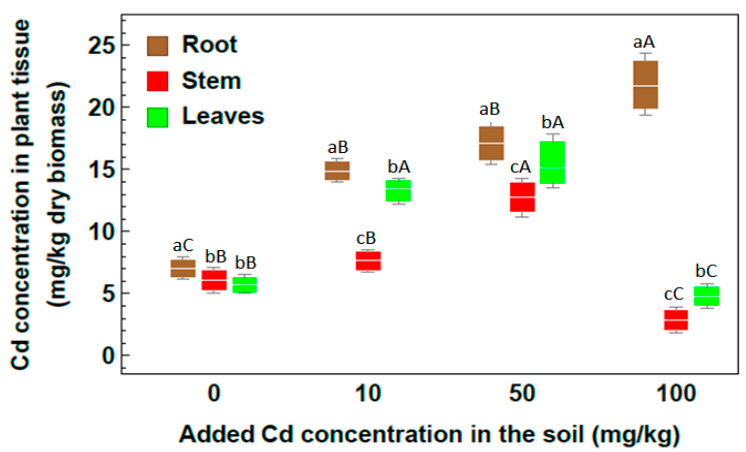
Figure 3. Concentration of Cd in plant organs of Rhazya stricta grown in soil treated with 10, 50 and 100 mg Cd/kg soil in an open greenhouse. Different lowercase letters indicate significant differences between plant parts for each soil metal concentration, and different capital letters indicate a significant difference between soil metal concentrations for each plant part ( p < 0.05).